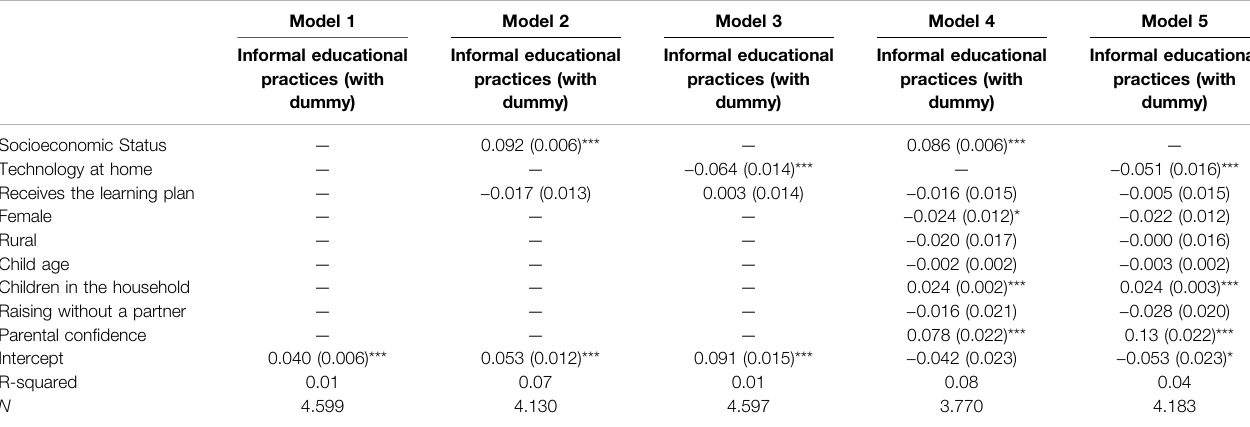
TABLE 5 | Regression model for informal educational